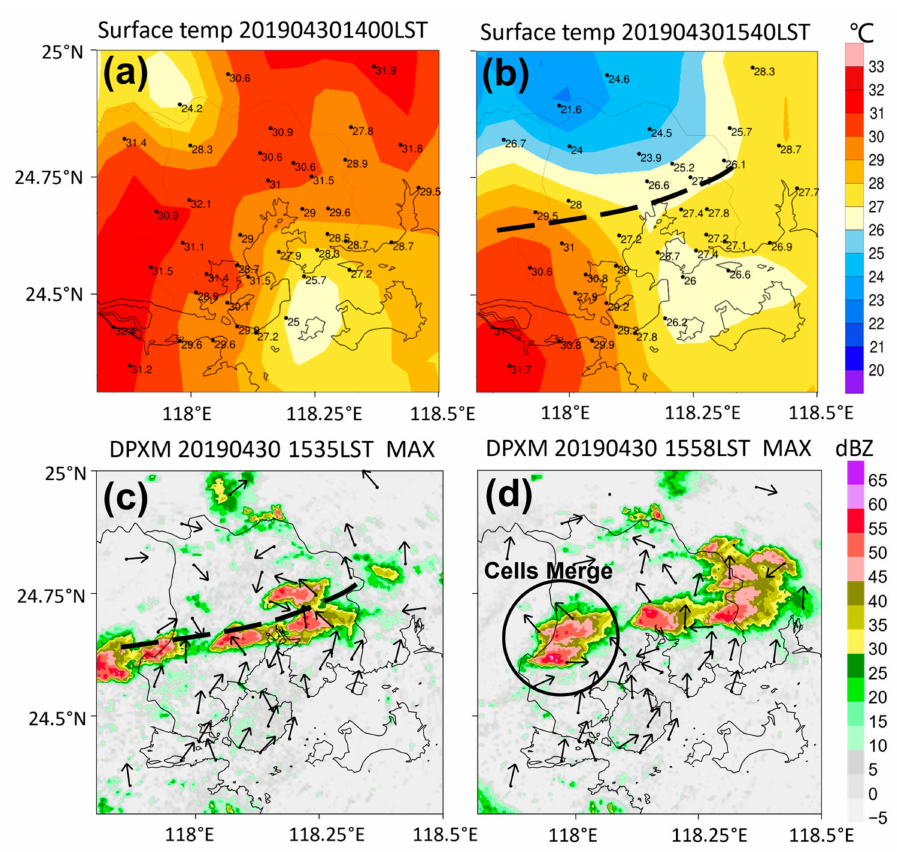
Figure 5. The surface temperatures (shaded; unit: ◦ C) at 14:00 LST ( a ) and 15:40 LST ( b ) and the surface wind field (arrow, units: m s − 1 ) and the radar composite reflectivity (shaded, units: dBZ) at 15:35 LST ( c ) and 15:58 LST ( d ) on 30 April 2019. The dashed line in ( b , c ) indicates the surface convergence